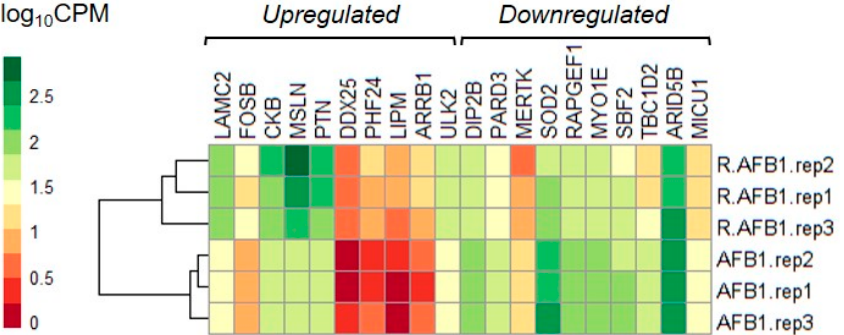
Figure 3. Heatmap of top-10 up- and downregulated genes by R+AFB1 co-treatment (vs. AFB1). The graph was constructed in R environment using the pheatmap package and using as input the normalized log 10 CPM (Counts Per Million). R = resveratrol; A = AFB1. Among the top-10 downregulated genes, superoxide dismutase 2 (SOD2; logFC = − 1.30) showed the highest fold change. A further gene involved in regulating oxidative stress and inhibited in R + AFB1 co-treated cells was mitochondrial calcium uptake 1 (MICU1; logFC = − 0.97). Besides, genes with a role in apoptosis were also found, i.e., MER proto- oncogene, tyrosine kinase (MERTK; logFC = − 1.30), Rap guanine nucleotide exchange factor 1 (RAPGEF1; logFC = −